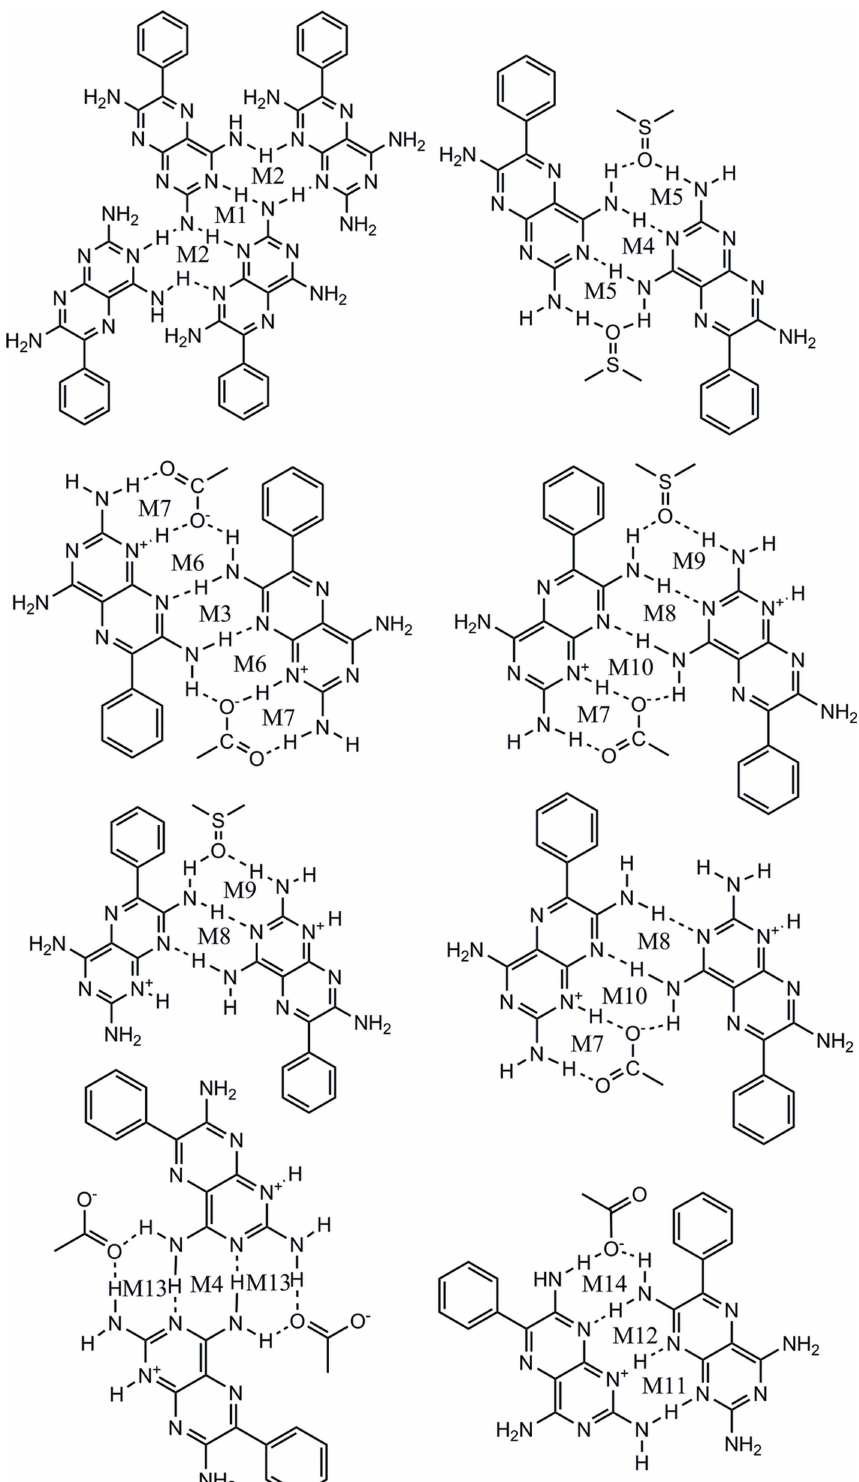
Figure 21 Supramolecular tape motifs found in 1 and adducts of 1 observed in this